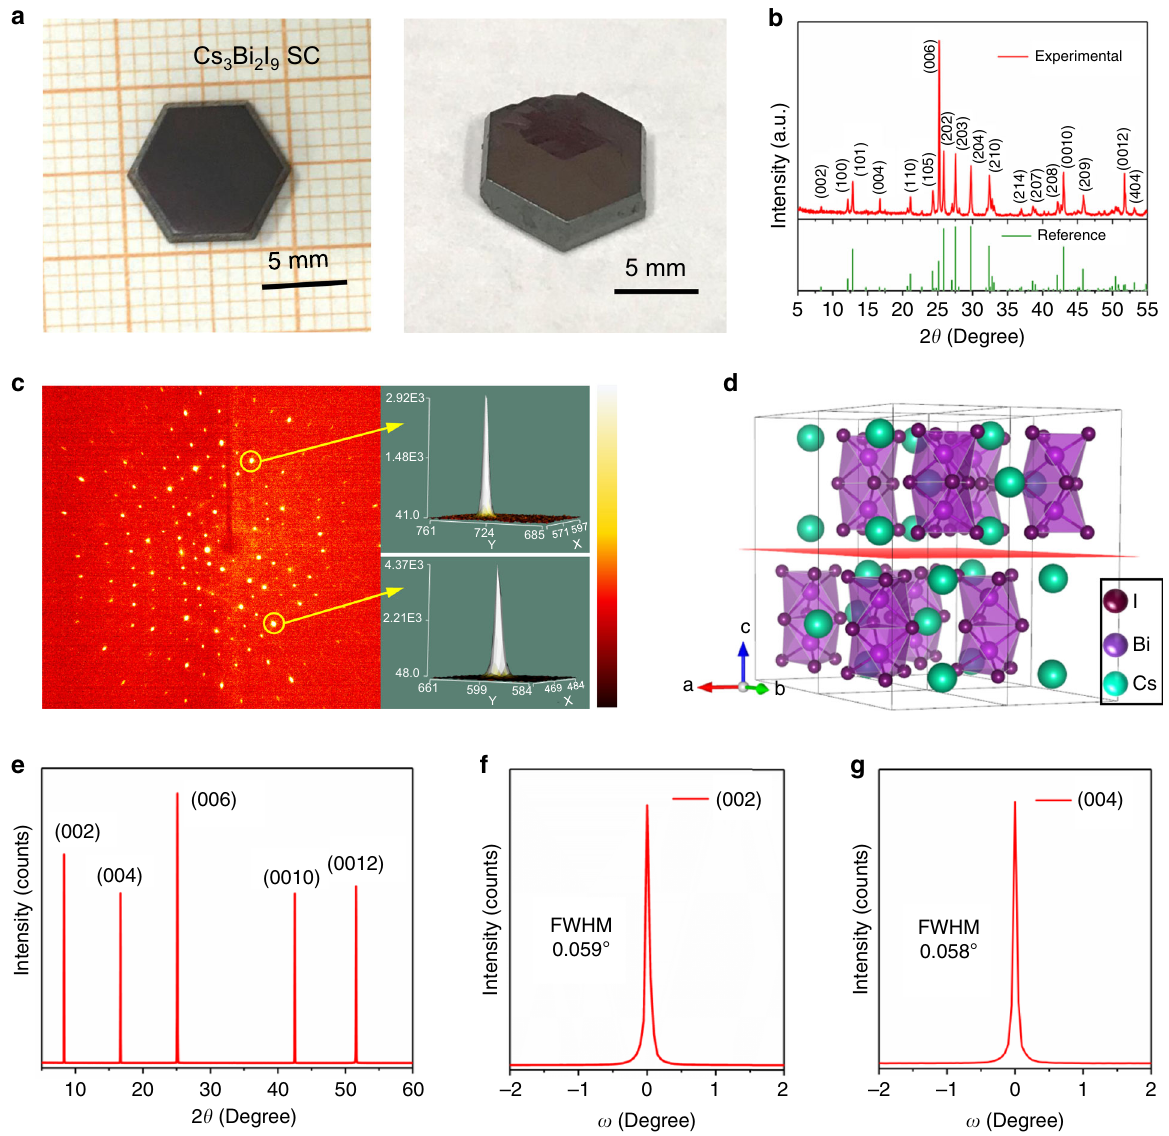
Fig. 2 Structural of Cs 3 Bi 2 I 9 PSC. a Photographs of representative Cs 3 Bi 2 I 9 PSCs. b Powder XRD patterns of the Cs 3 Bi 2 I 9 PSC. c Single-crystal X-ray diffraction spots of a Cs 3 Bi 2 I 9 PSC. d Con fi guration of 2 × 2 × 1 supercell Cs 3 Bi 2 I 9 . e XRD 2 θ scan on the (002) facet of the Cs 3 Bi 2 I 9 PSC. f , g High-resolution XRD rocking curves of the diffraction peaks at (002) and